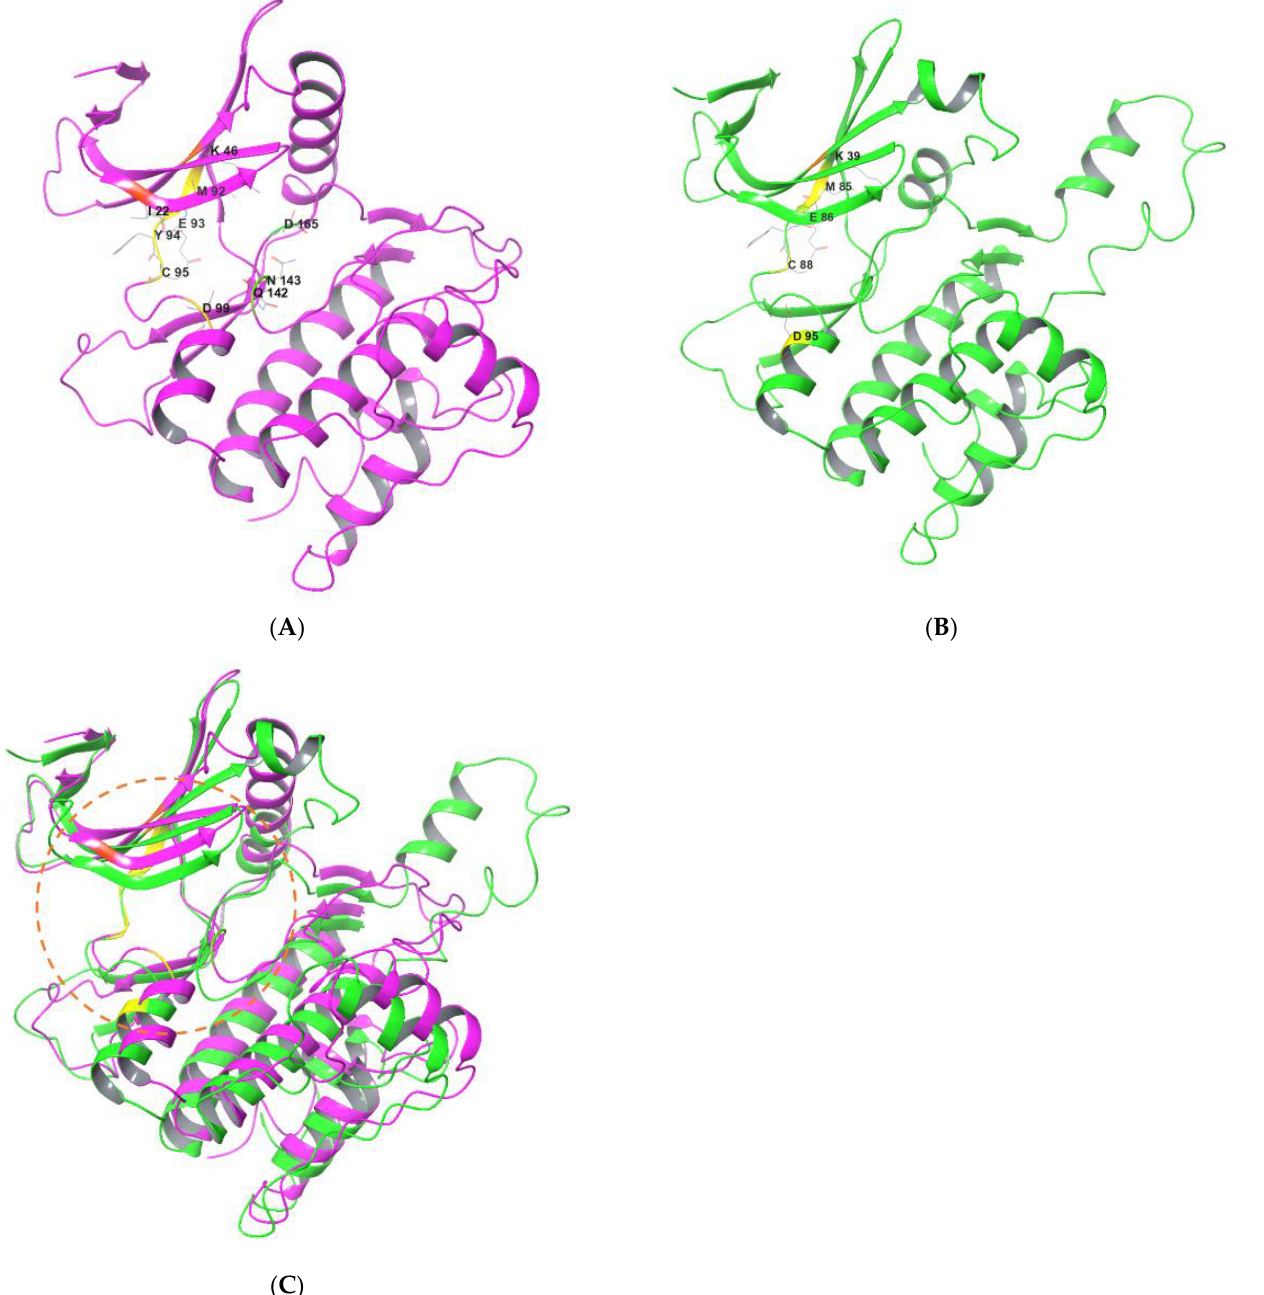
Figure 2. Structures of N-terminal kinase domain of ULK1 and ULK2. ( A ) Magenta: ULK1 KD (PDB ID:6QAS). ( B ) Green: ULK2 KD (PDB ID:6QAV). ( C ) Comparison of ULK1 and ULK2 KDs. a Key residues interacting with inhibitors are highlighted and labeled. Ligands and water molecules are omitted; b ULK1 and ULK2 KDs were superimposed with the Quick Aligh tool in Maestro 13.3 (Schrodinger Inc.). Orange circle: Binding site for ATP or inhibitors.